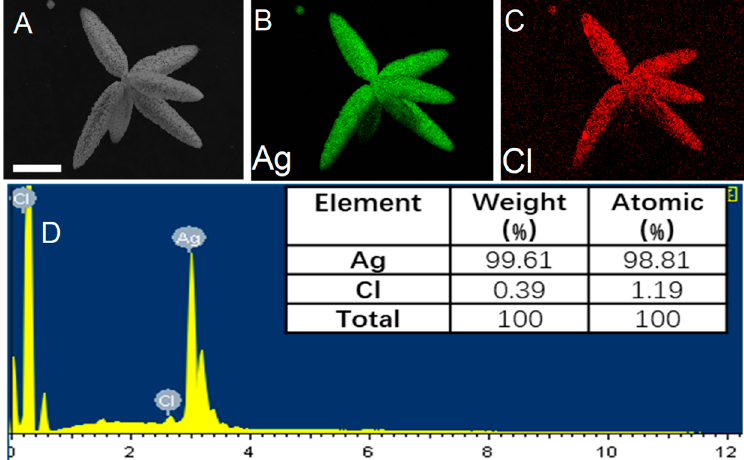
Figure 5. ( A ) SEM image of Ag@AgCl microstructure (R = 0.9); ( B ) and ( C ) EDS elemental mapping of Ag@AgCl indicating the Ag and Cl elemental distribution. ( D ) The corresponding EDS elemental spectrum of Ag@AgCl microstructure. Scar bar: 8 μ m (a–c).